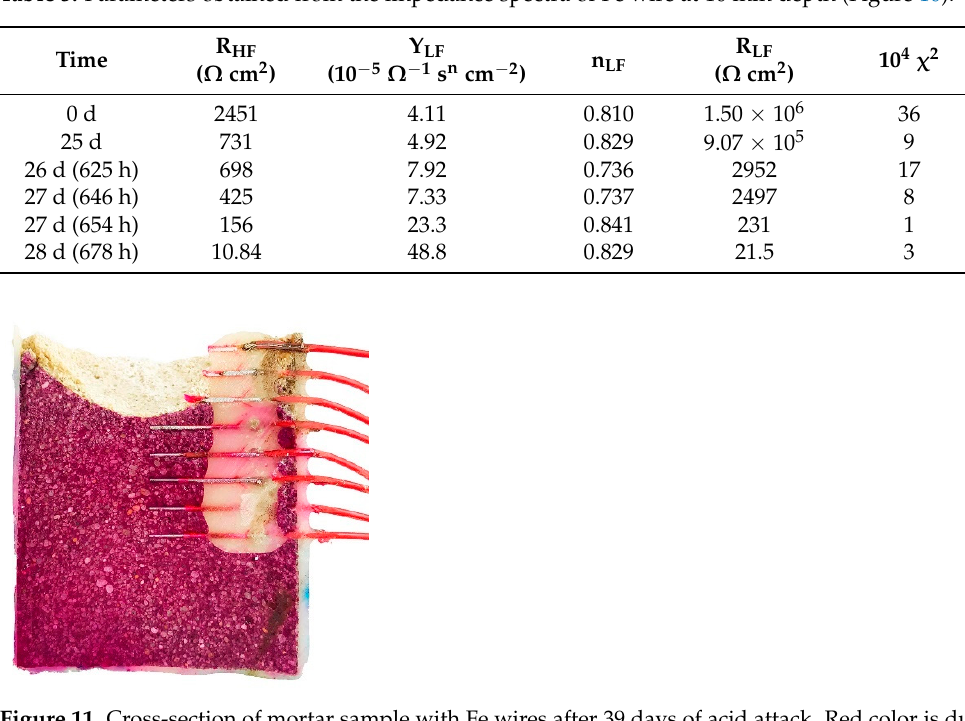
Figure 11. Cross-section of mortar sample with Fe wires after 39 days of acid attack. Red color is due to the presence of phenolphthalein identifying the region with pH > 9.